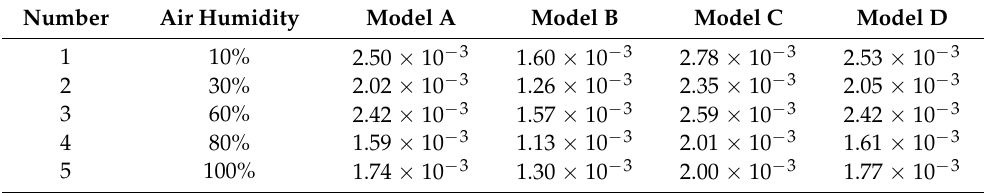
Table 4. Chi-square values of the model fitting results under different air